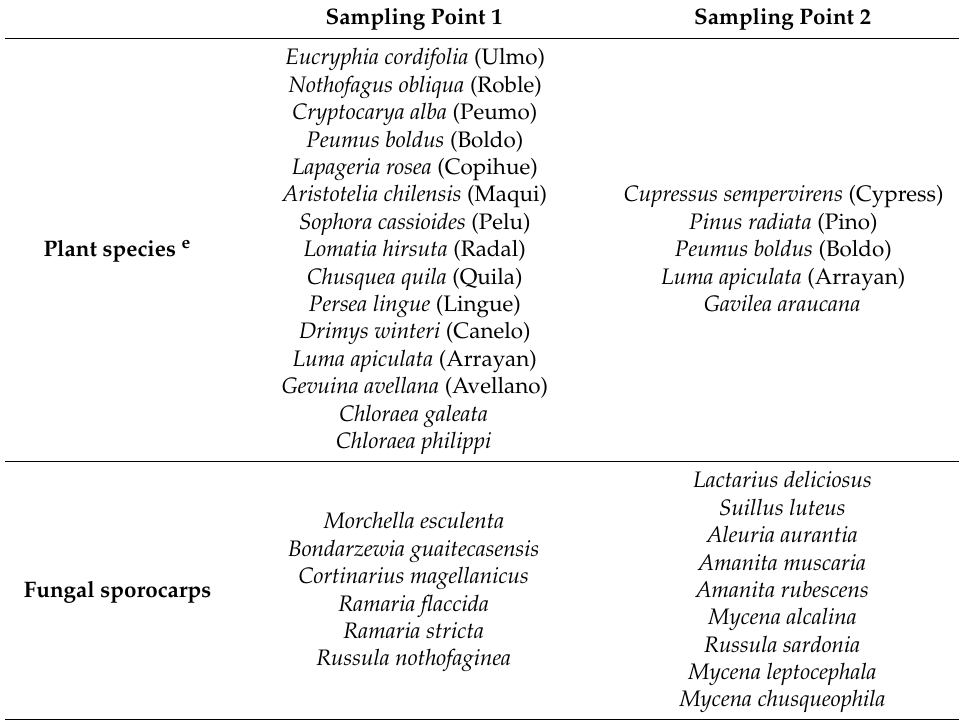
Table 1. Cont. Sampling Point 1 Sampling Point